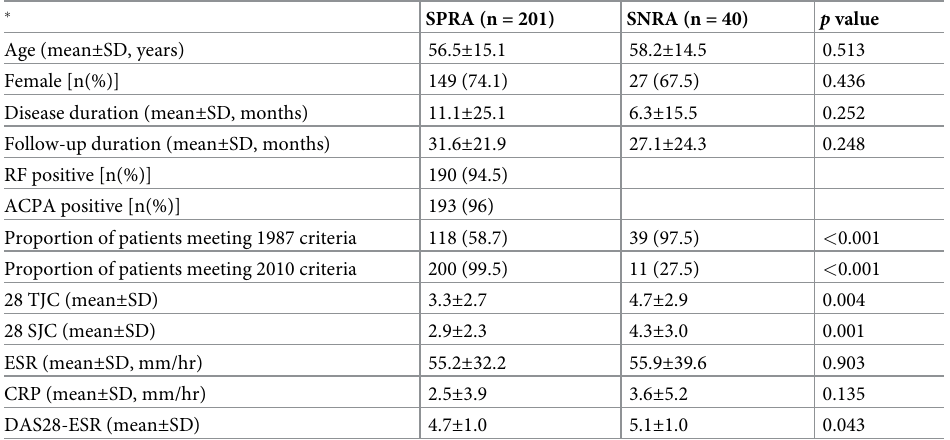
Table 1. Baseline patient